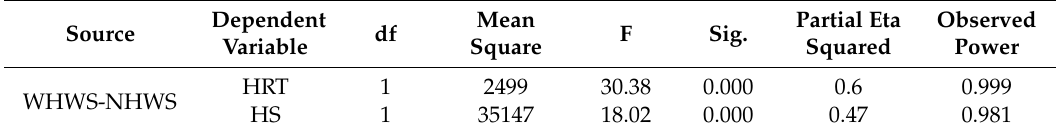
Table 5. Test of within-subject effects.